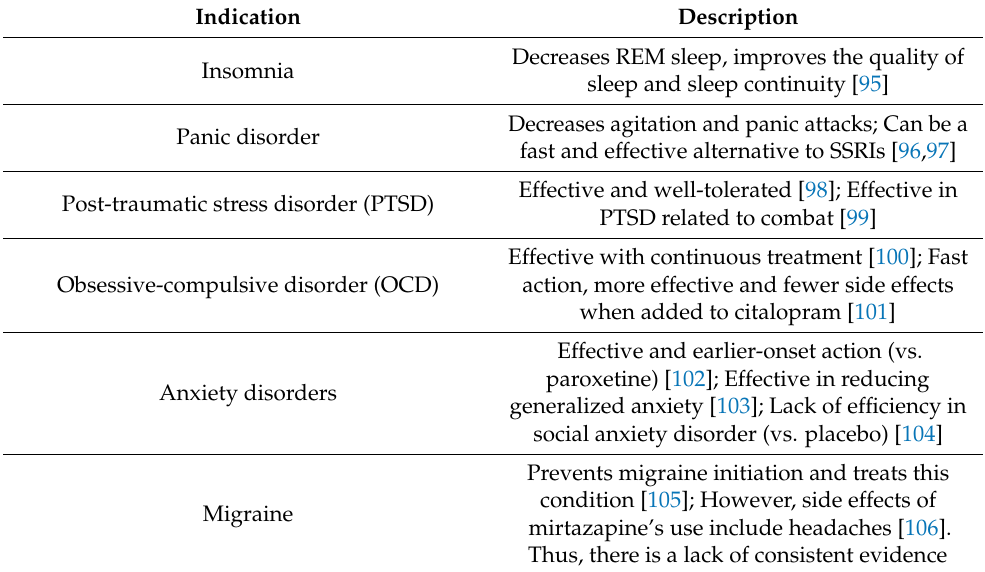
Table 2. Indications of mirtazapine in neuropsychiatric disorders that do not include